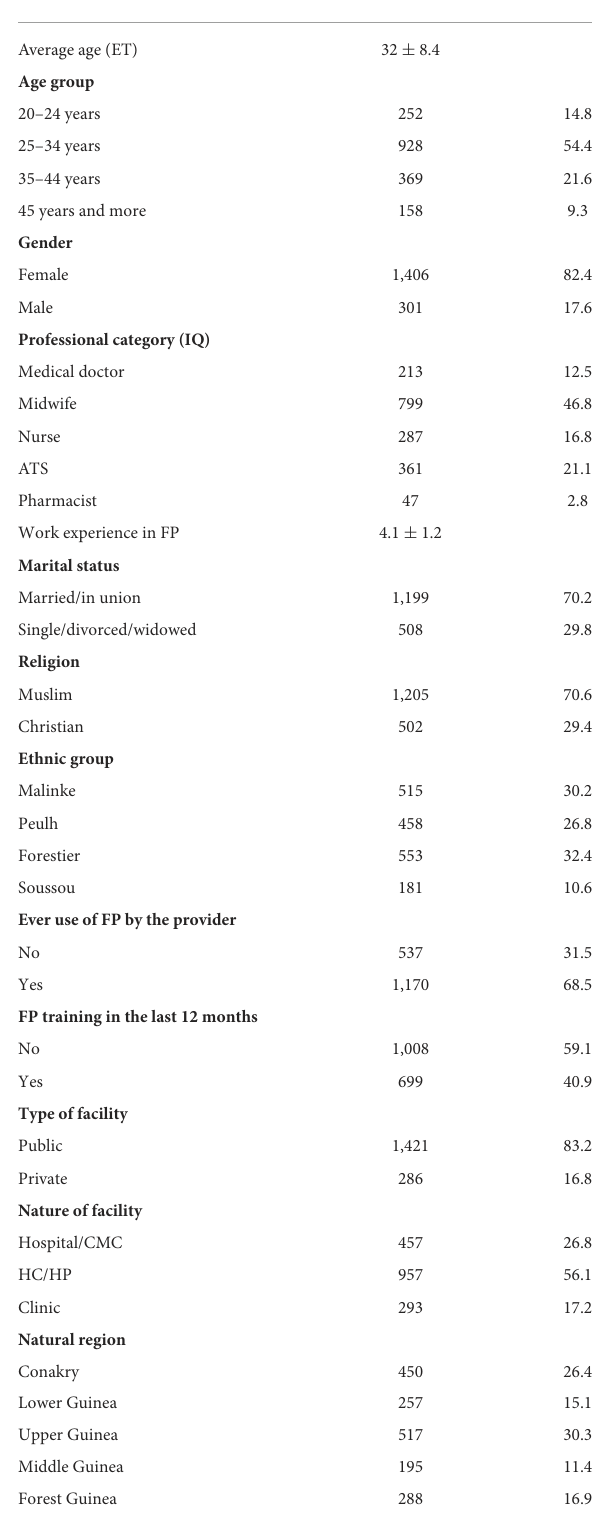
TABLE 1 Demographic characteristics of surveyed providers on contraception use among adolescents and youth, Guinea, January–March 2021 ( n =